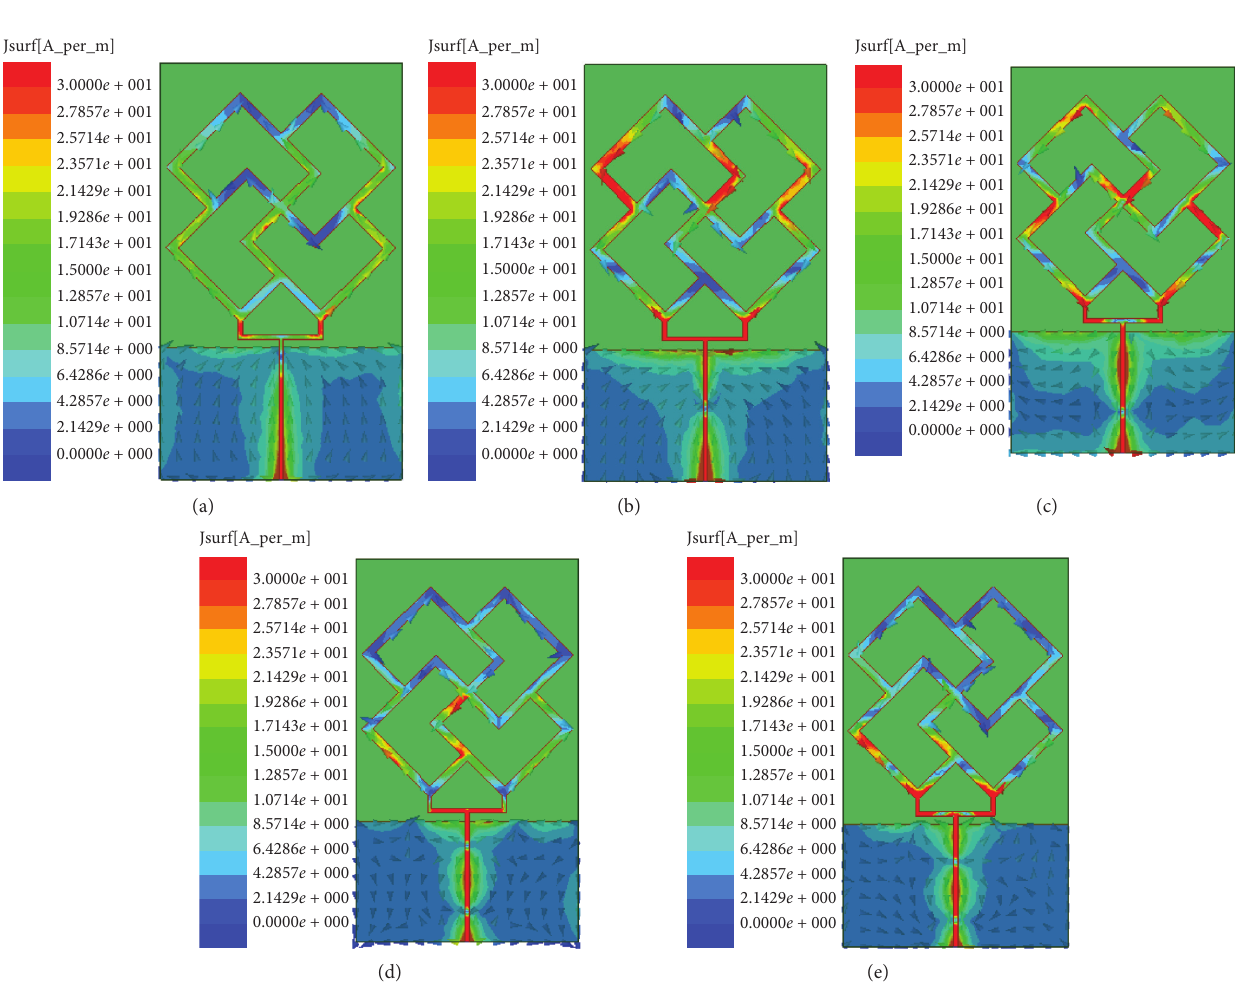
Figure 14: The current amplitude and vector distribution on the surface of a microstrip antenna with a cross structure imitating classical grilles: (a) 1.45GHz,(b) 2.45GHz, (c) 3.85GHz,(d) 5.13GHz, and (e)